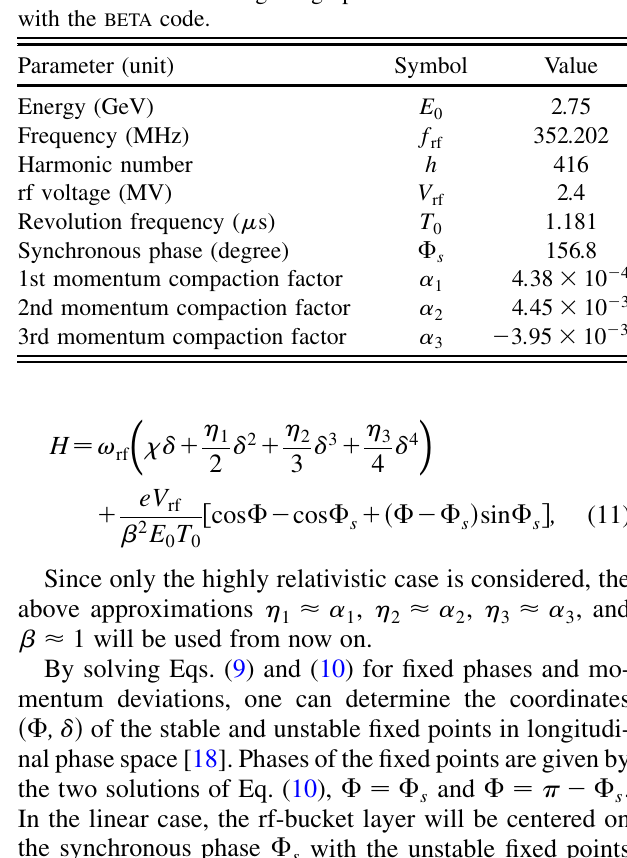
Using the SOLEIL nominal operational parameters (see Table I), the numerical solutions are f (cid:2) 1 ¼ 0 ; (cid:2) 2 ¼